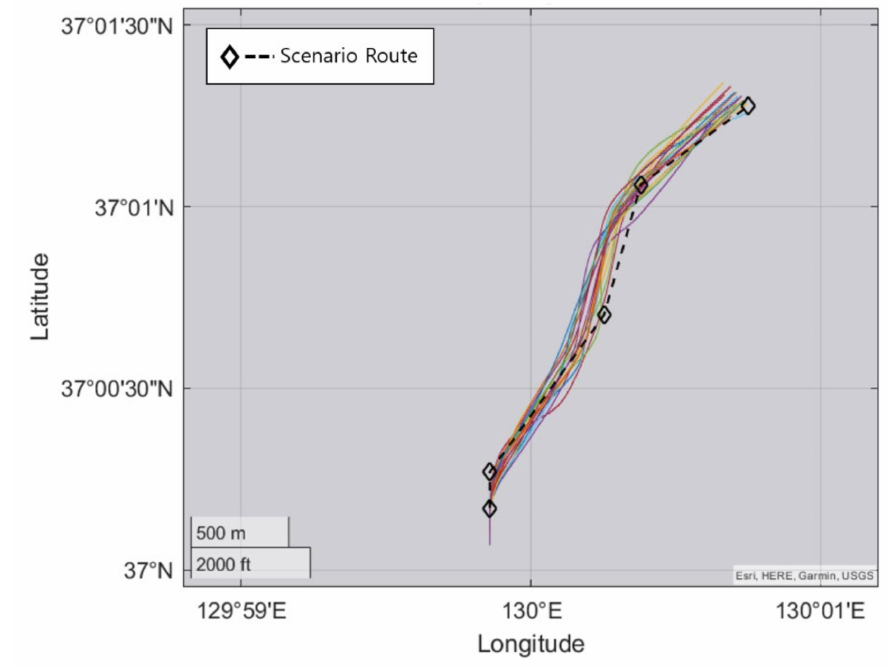
Figure 6. Navigation performance result: group